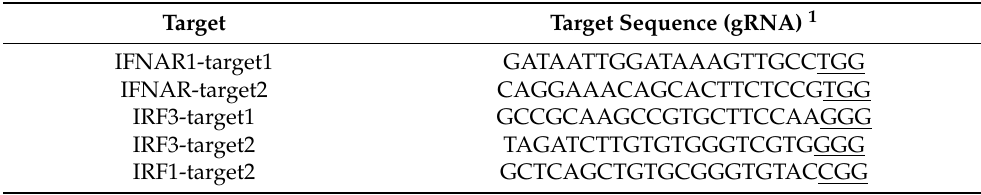
Table 1. Target sequences (gRNA).